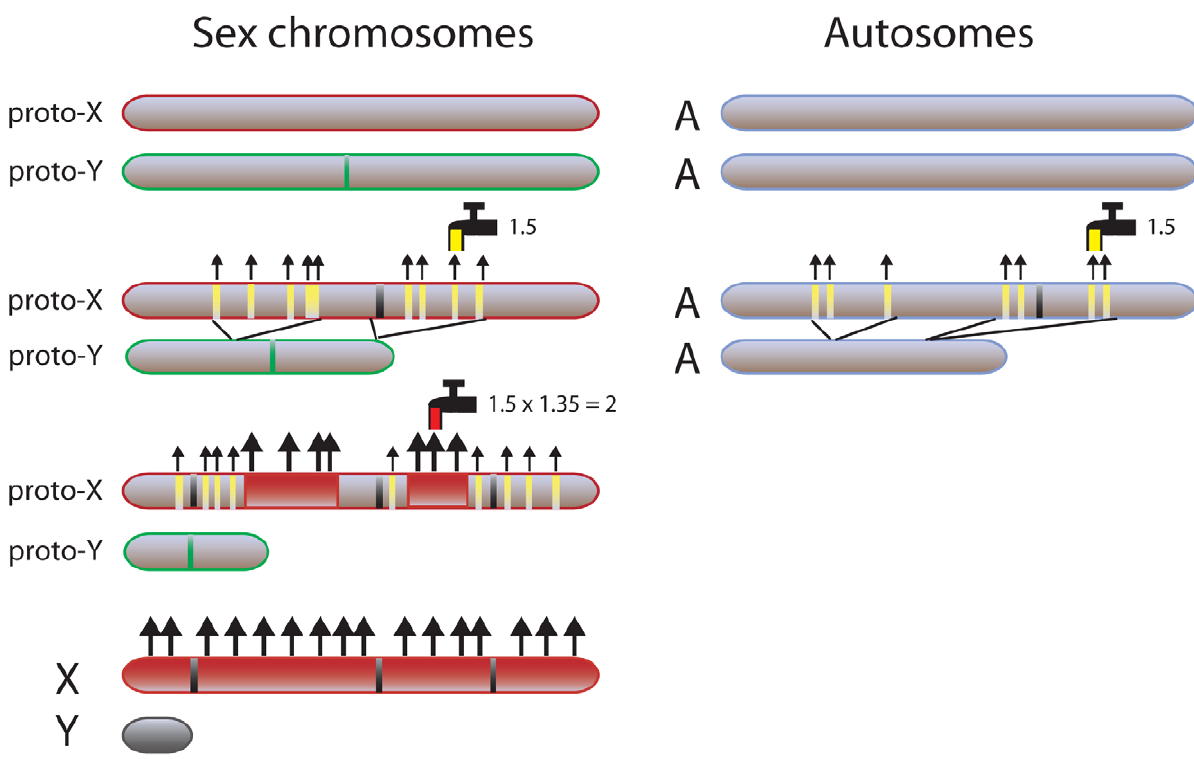
Figure 2. Evolutionary model of sex chromosome dosage compensation compared to the basal compensation response of an autosome after a deletion. After the proto-Y chromosome evolved a gene with a male-determining function (green bar), it became subject to gradual gene loss on a gene-by-gene or segment-by-segment basis due to lack of recombination between the proto-sex chromosomes. If the lost region on the proto-Y chromosome contained dosage sensitive genes such as those that encode transcriptional factors (yellow bars), this would have triggered a basal dosage compensation response (yellow faucet) on the proto-X chromosome and led to a partial (1.5-fold) increase of expression (small arrows). The same basal dosage compensation process would also modify a deleted region on an autosome (A) in an abnormal cell. Dosage- insensitive genes (black bars) may escape this process. When broader regions were lost on the proto-Y chromosome, the collective imbalance effects of multiple aneuploid genes would have become highly deleterious and the increased load of aneuploidy could have stressed the basal mechanism of dosage compensation. Survival was achieved by recruiting regulatory complexes such as the MSL complex (red faucet) to aneuploid X segments (red regions), to further increase gene expression (big arrows) and rescue the X monosomy. This feed-forward sex chromosome–specific regulation would provide 1.35-fold increase in expression, which together with the basal dosage compensation (1.5-fold increase) would achieve the approximate two-fold upregulation of most genes on the present day X chromosome. In contrast, large-scale deleterious autosomal aneuploidy would be lost due to lack of a specific sex-driven compensatory mechanism.